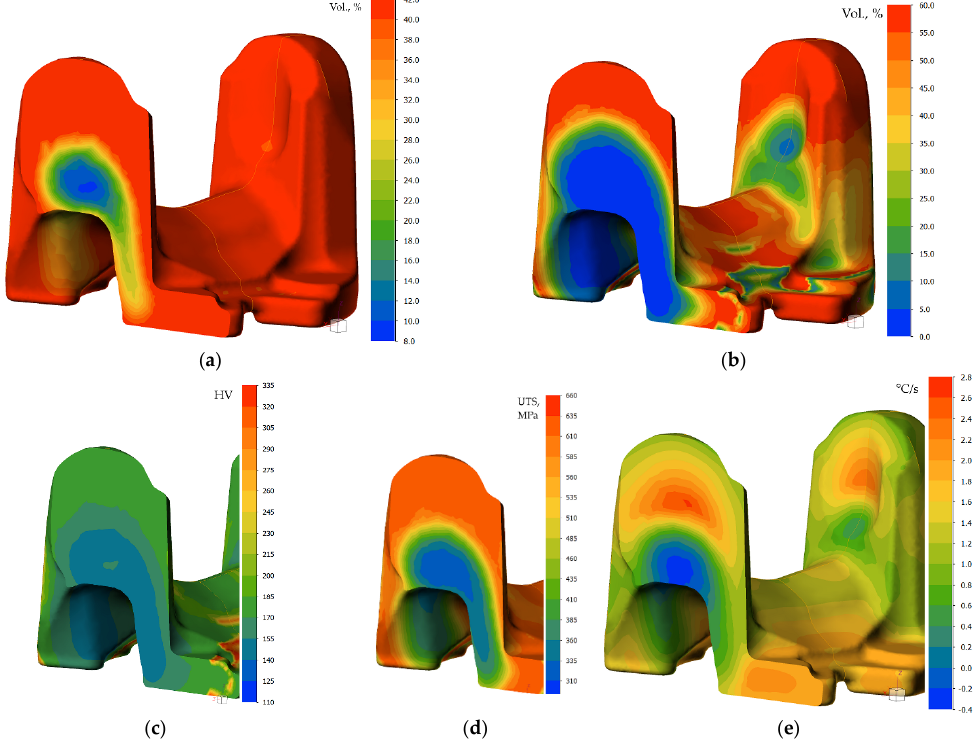
Figure 17. Numerically calculated volume fractions of: ( a ) ferrite, and ( b ) pearlite, and ( c ) hardness, ( d ) ultimate tensile strength, and ( e ) instant cooling rate for cooling time 100 s—after sprayer 2.